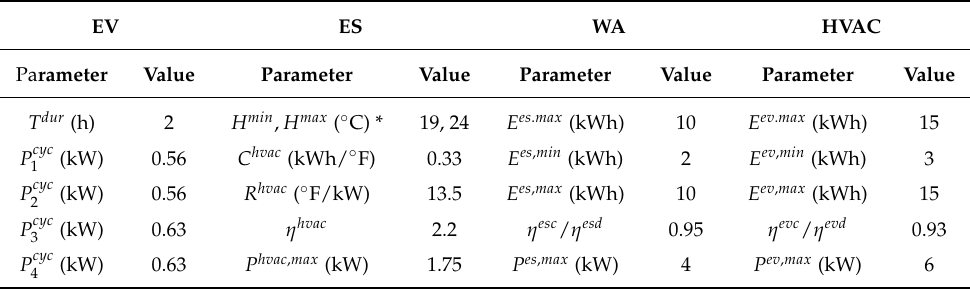
Table 3. Distributions of the operating parameters of the EV, ES, WAs, and HVAC.